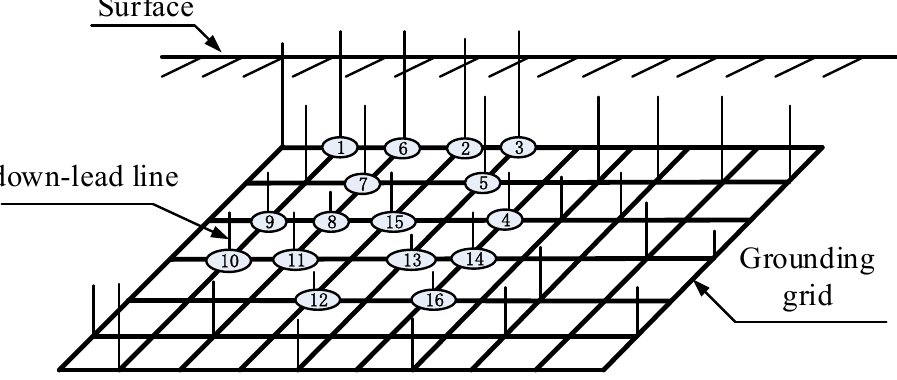
Figure 2. The cycle measurement of potentials.